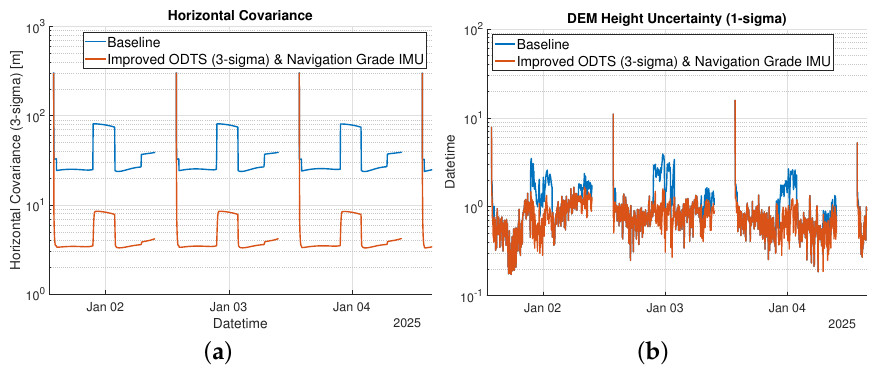
Figure 15. Performance of the LCNS position solution. ( a ) shows the horizontal (2D) covariance of for the baseline and improved scenarios (considering an improved ODTS accuracy and navigation-grade IMU, while ( b ) shows the 1-sigma uncertainty of the DEM measurement for the same scenarios as defined in ( a ).